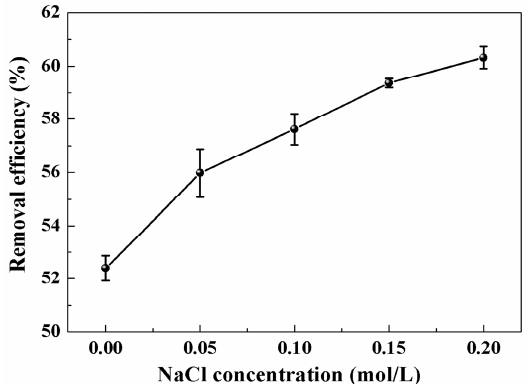
Figure 9. Effect of pH on the removal rate of MB (dosage of the adsorbents: 1.0 g/L; initial concentration: 200 mg/L).